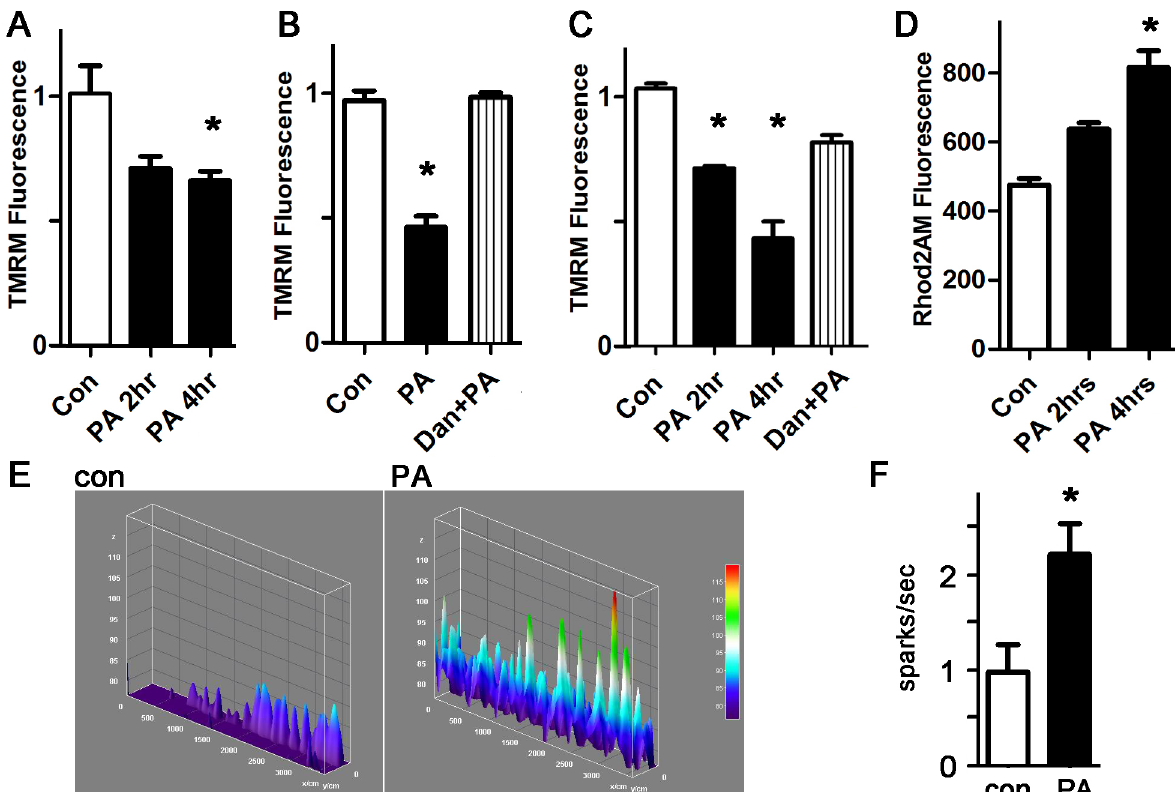
Fig 3. Palmitate depolarizes the mitochondrial inner membrane potential and causes mitochondrial calcium overload from increased sparks. A. Representative experiment done with cardiomyocytes in triplicate, height is TMRM fluorescence minus background, in live cells, expressed in arbitrary units, mean + SEM. PA = palmitate 200 μ M. B. Dantrolene prevents the loss of inner membrane potential. Dan = dantrolene 1 μ M. C. Similar experiment using H9c2 cells and TMRM readout. D. Cardiomyocytes with Rhod2AM readout indicating mitochondrial calcium. For all panels, means are significantly different by ANOVA, * = sig different from control by post-hoc test. E. Representative line-scan sparks experiments from cardiomyocytes; height is spark amplitude, over time. F. Graph of sparks, normalized to control, n = 10 – 11, * = p <